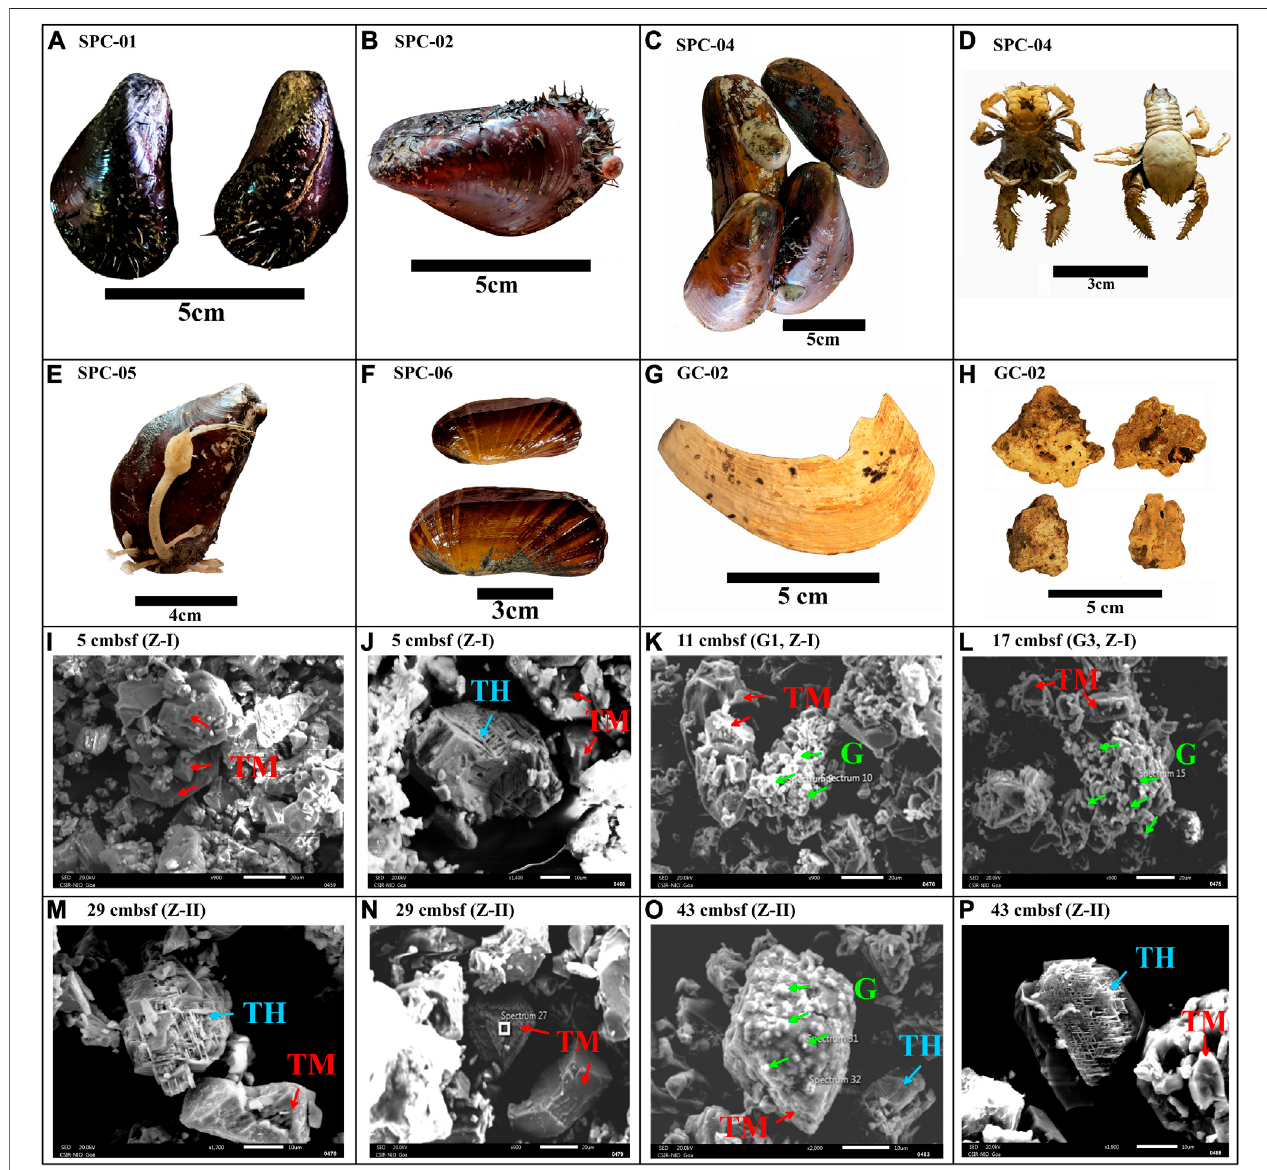
FIGURE8| Photographsshowingoccurrenceof (A,B,C,E) : Bathymodiolus sp (D) :Decapodcrustaceans(squatlobsters) (F) :Acharaxsp.foundatthespadecore (surface) locations (G) calyptogena sp., shell fragment, and (H) authigenic carbonates found at 48 cmbsf in GC-02 location (I – P) : Scanning electron microscopy on magnetic extracts from different sediment core depth intervals (Relict seep site: SSD-45/Stn-11/GC-02). TM, titanomagnetite; TH, titanohematite; and G, greigite).